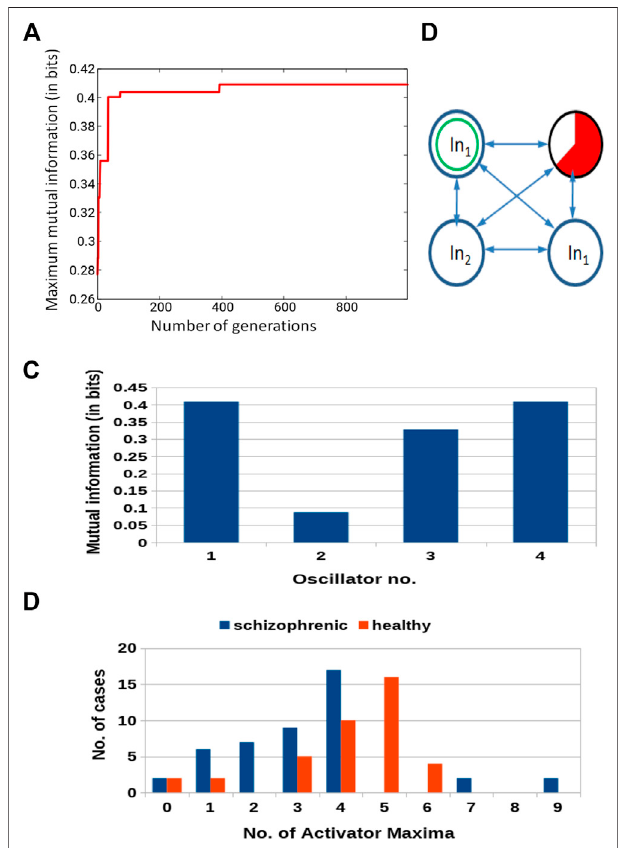
FIGURE 7 | Results for 4-oscillator network (cf. Figure 2B ): (A) The progress of optimization; the Fitness as a function of generation number. (B) The structure of the optimized network. Notation as in Figure 5B . (C) The mutual information I ( G ; O j ) for j ∈ {1,2,3,4}. The function j → I ( G ; O j ) has the maximum at j =1. (D) The distribution of the numbers of cases for which a given number of activator maxima was observed on oscillator # 1 for records representing schizophrenic and healthy patients.